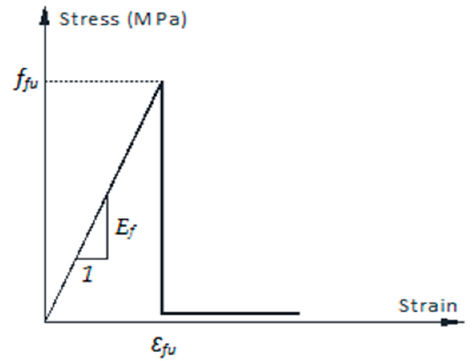
Figure 6. Stress–strain curves for CFRP laminate.